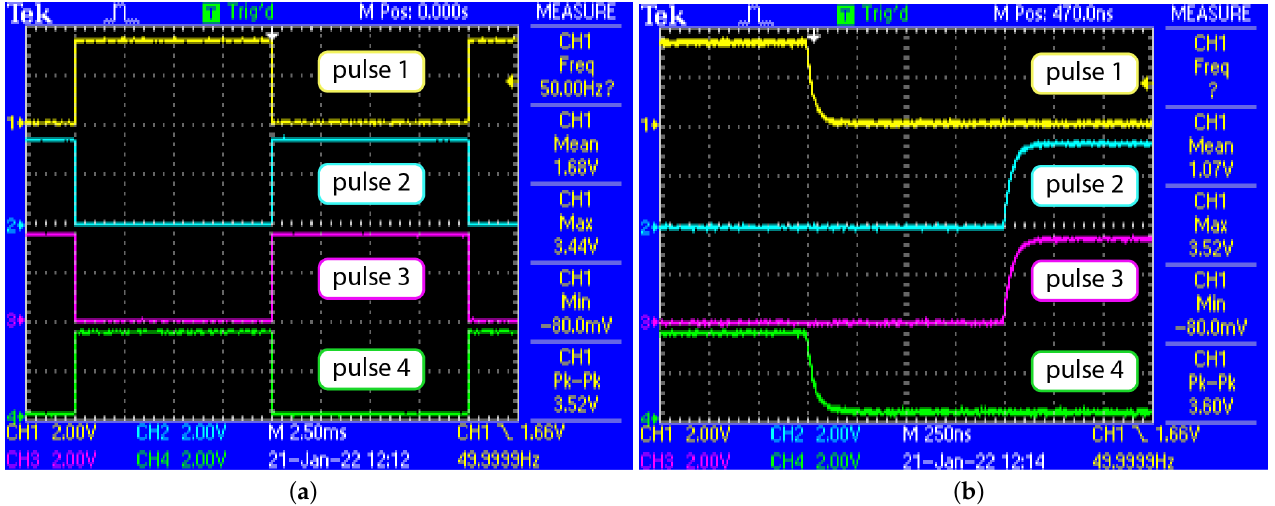
Figure 25. Square-wave pulses for an H-bridge converter and respective deadtimes. ( a ) Square-wave pulses for H-bridge. ( b ) Deadtimes between